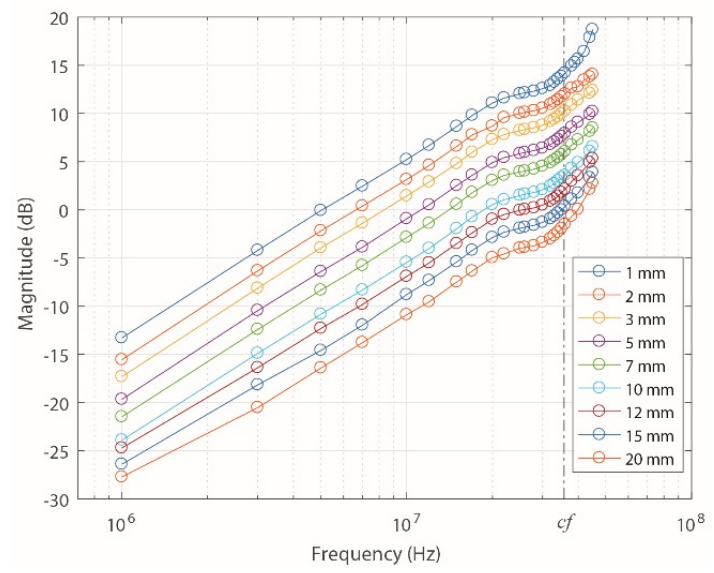
Figure 11. Experimental frequency responses of the ILS for different values of a .